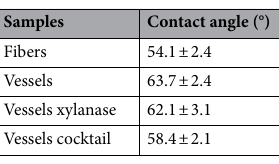
Table 7. Fibers and vessels (treated and untreated) water contact